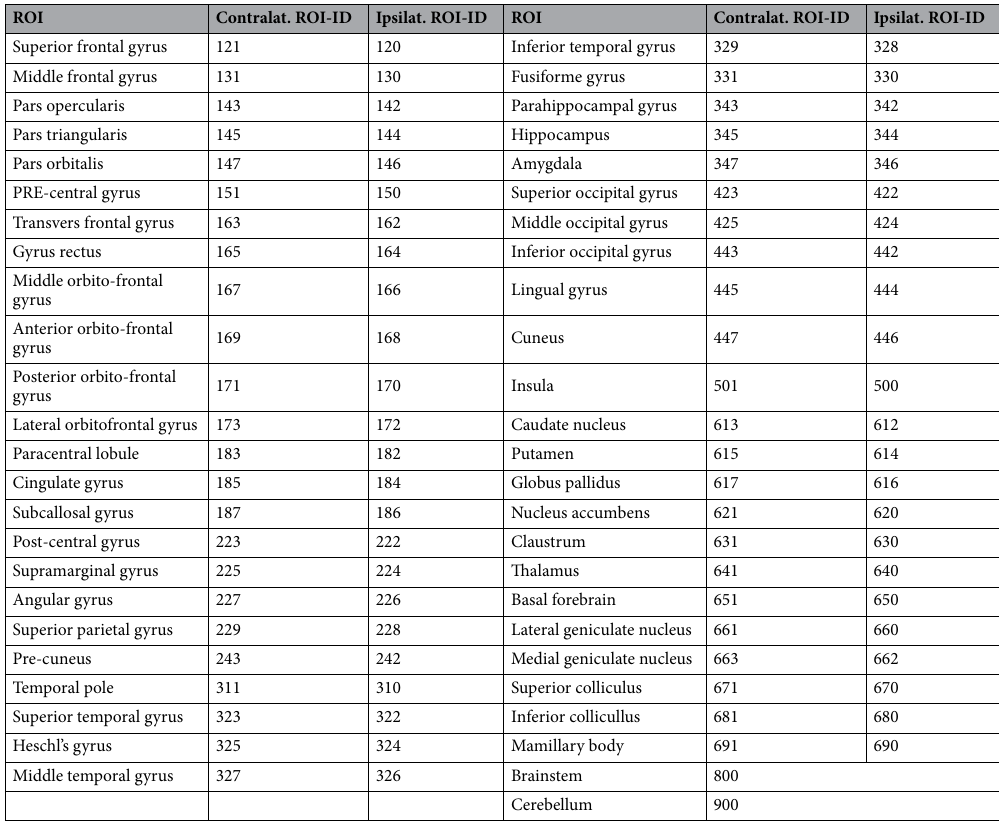
Table 2. Region-of-interest (ROI).